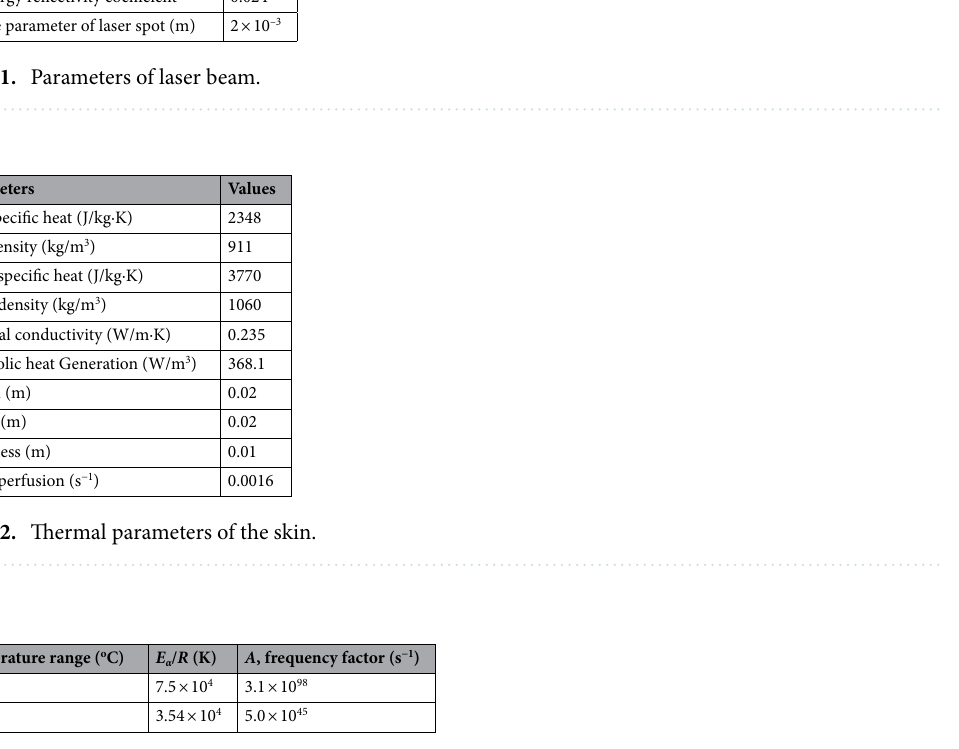
Table 3. Parameters for thermal damage